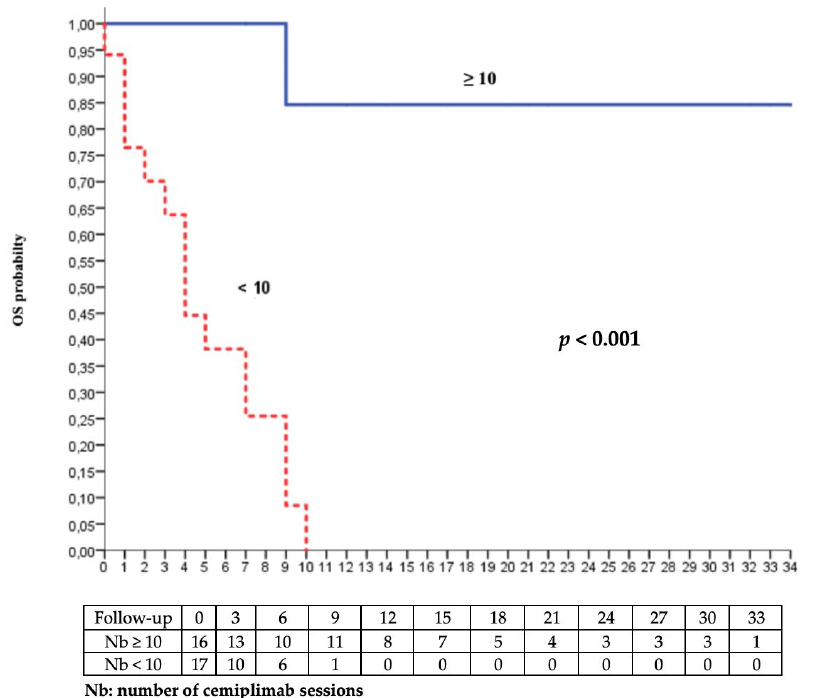
Figure 3. Receiver operating characteristic (ROC) curve.